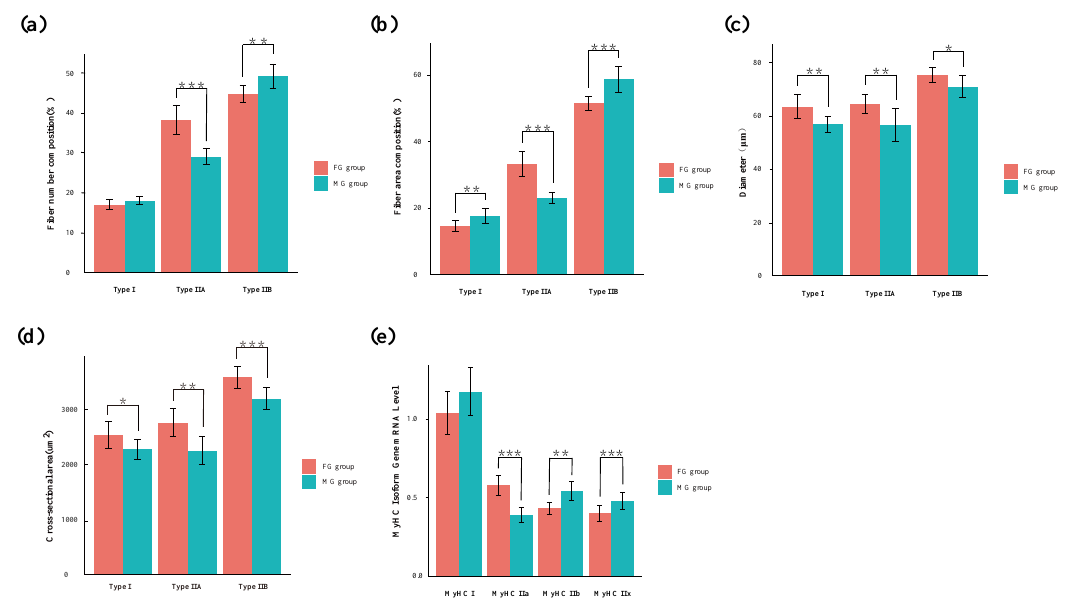
Figure 1. Serial sections of LT muscle stained with ATPase. FG group, flatland-grazing group; MG group, mountain-grazing group; bar: 200 μm.